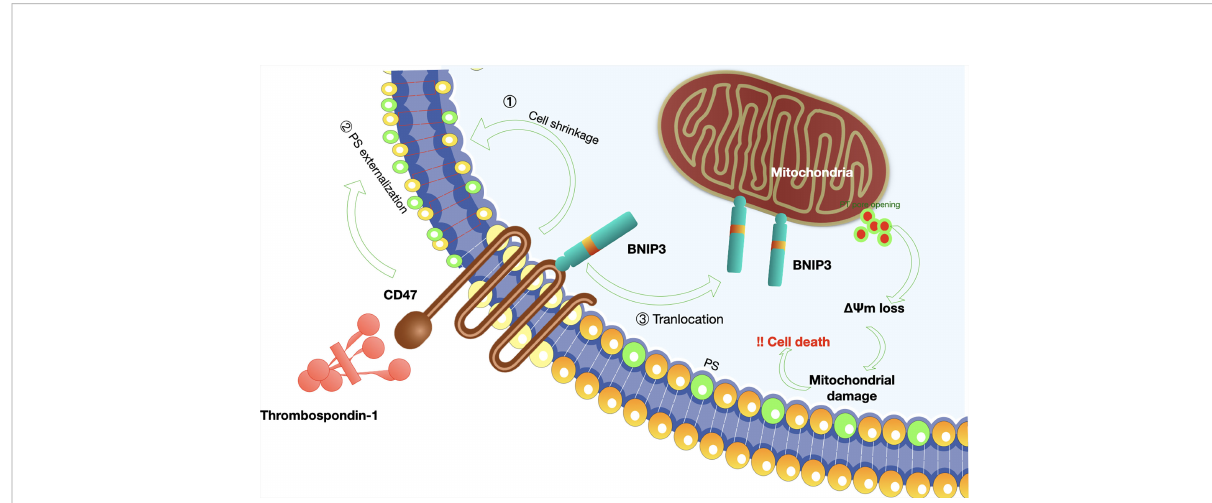
FIGURE 5 Mechanisms of CD47-induced caspase-independent cell death.CD47 induces a caspase-independent cell death, characterized by intact or slightly modi fi ed nuclei, reduced cell viability (80). The process of cell apoptosis includes PS (phosphatidylserine) exposure, disruption of mitochondrial function, and cytoskeleton rearrangement (1): K+ is a critical component of volume regulatory response, and leakage of K+ is a simple way to accommodate a rapid decrease in cell volume; CD47-induced cell death was dependent on K+ ef fl ux (81); (2) Mechanisms involved in PS exposure remain poorly understood. Veronique M et al. proposed that CD47 ligation initially induce triggering of actin polymerization, perhaps via Cdc42/WASP pathway. This event then leads to mitochondrial changes including matrix swelling and DY m (mitochondrial transmembrane potential) loss, followed by PS exposure or bypass of mitochondria and direct induction of PS externalization (81); (3) In addition, Bcl-2 homology 3 (BH3)-only protein 19 kDa interacting protein-3 (BNIP3) is indispensable for the pro-apoptotic effect of CD47 (82). A simple model-based on the translocation of BNIP3 from the inner surface of the cell membrane to the mitochondria is